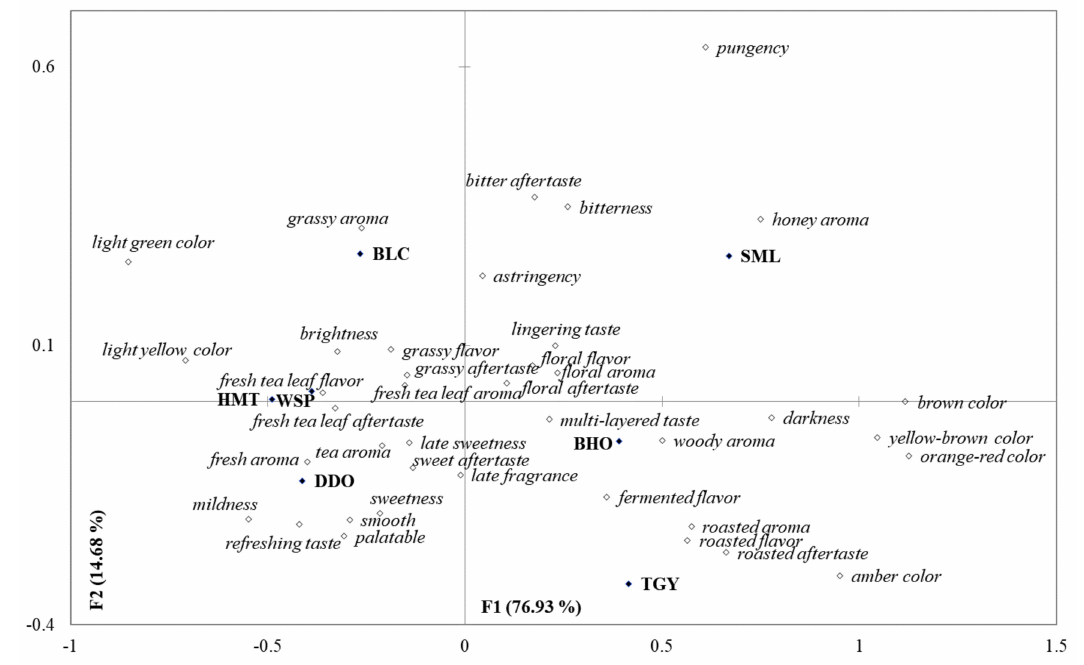
Figure 1. A bi-plot by correspondence analysis of the seven tea infusions in association with the 39 sensory attributes selected by more than 20% of participants. BLC: Bi-Luo-Chun green tea,